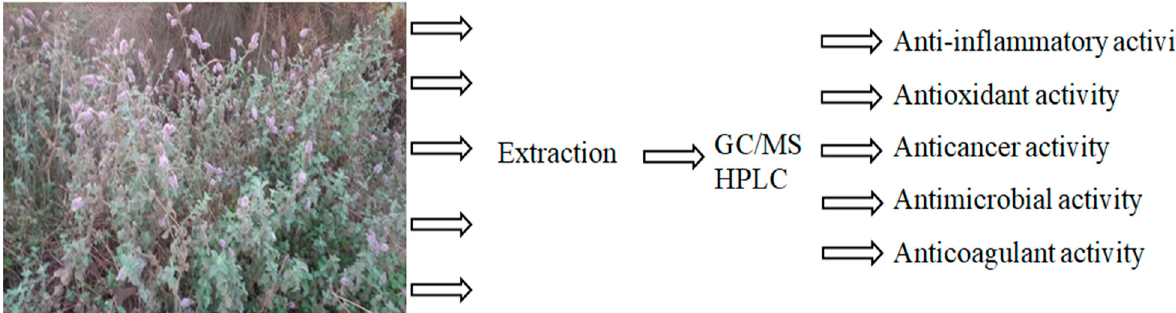
Figure 1. Diagram illustrating M. pulegium plants with the analysis methods and biological activities.